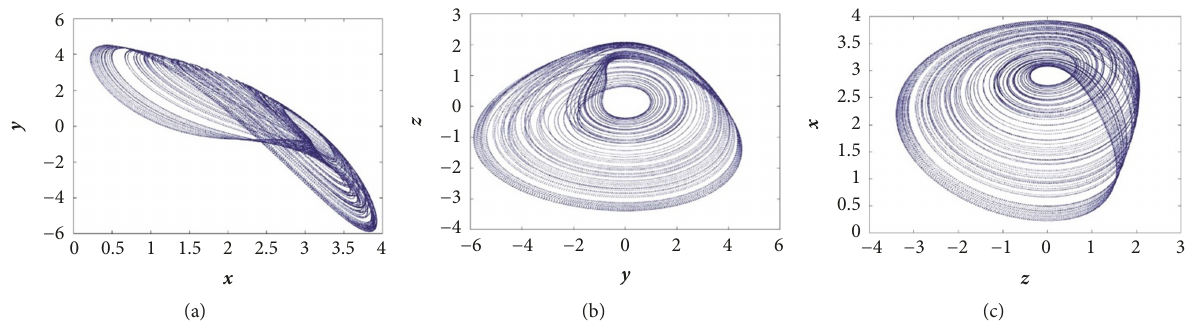
Figure 9: (Color online) Phase portraits of the FPGA implemented of proposed autonomous jerk oscillator with hardware-software co- simulation for parameter values 𝑎 = 3.3 , 𝑏 = 3 and initial conditions [1, 0, 0.5] with ℎ = 0.001